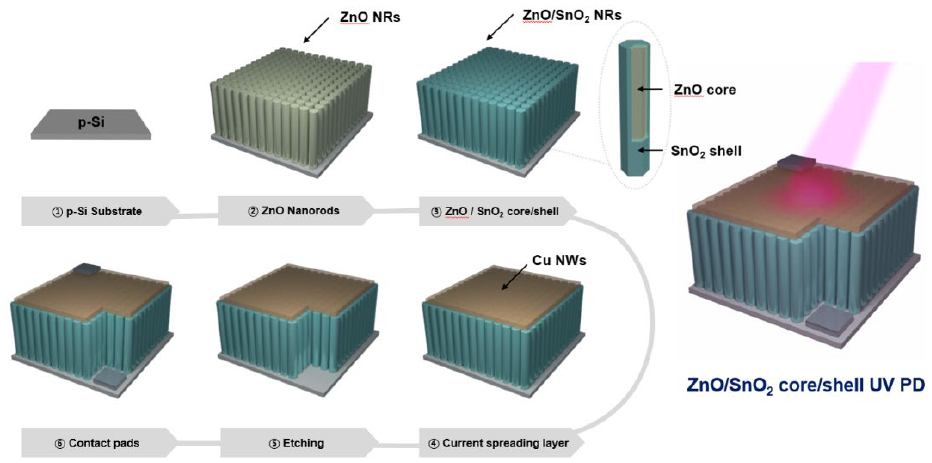
Figure 1. The fabrication process of the ZnO/SnO 2 core–shell photodetector.